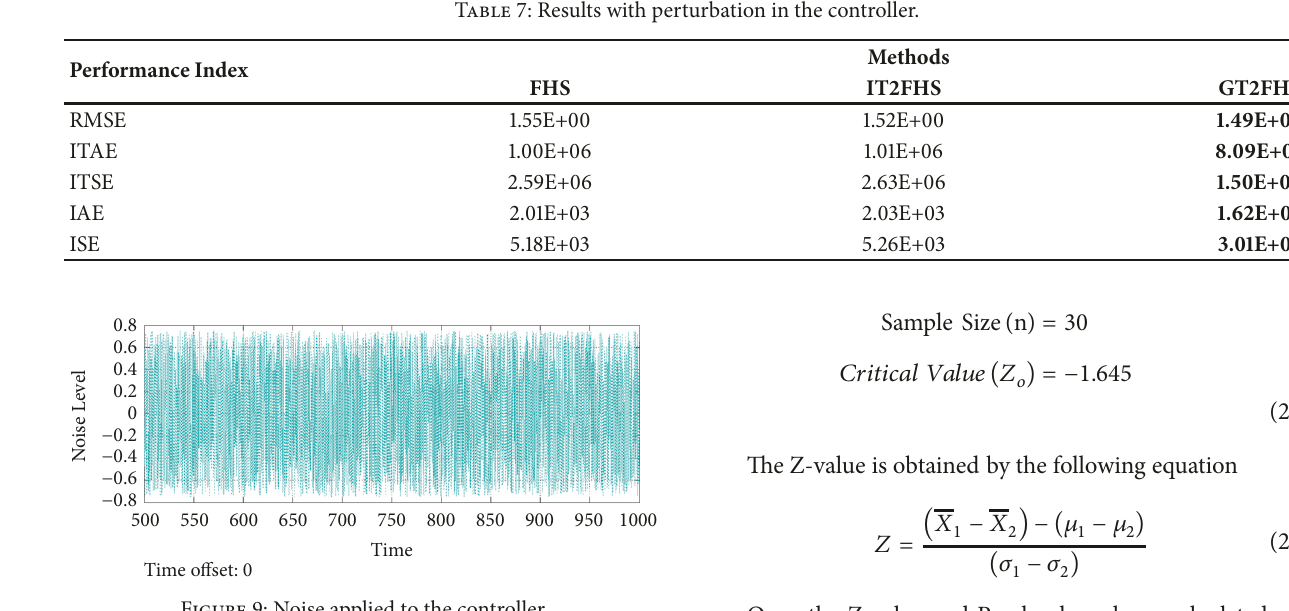
Figure 9: Noise applied to the controller.